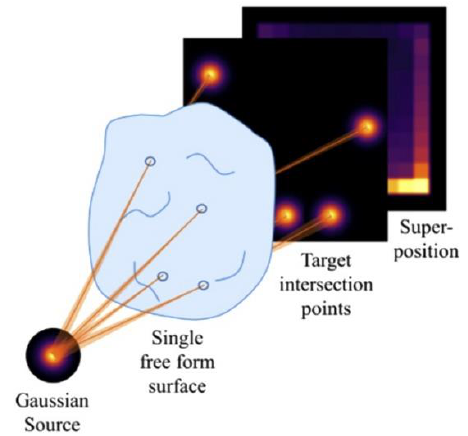
Figure 6. Diagram of the pinhole approach used to calculate the irradiance distribution generated by a freeform surface [110]. a freeform surface